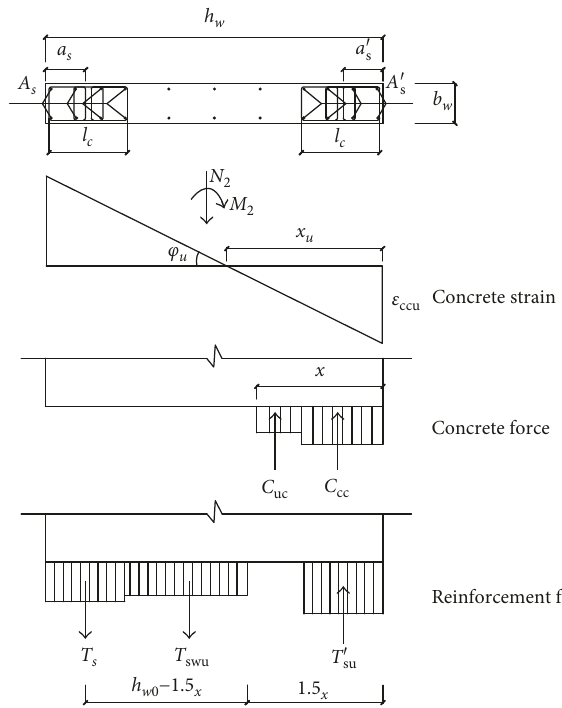
Figure 7: Stress and strain distribution profile in the ultimate